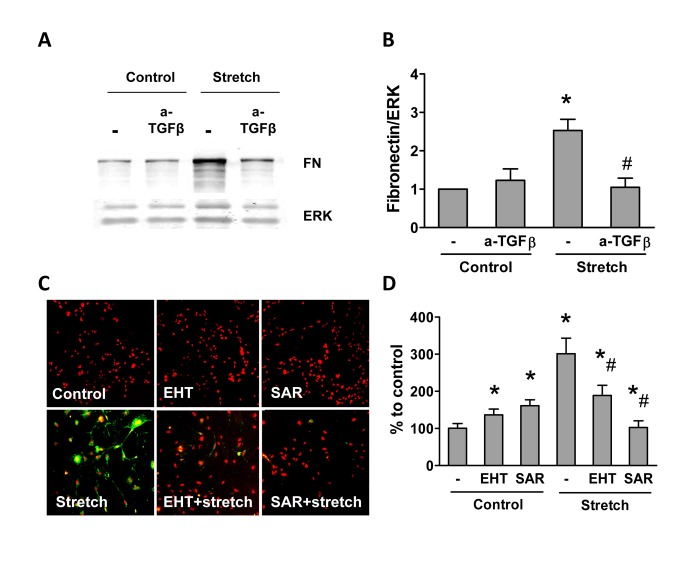
TGFβ mediates stretch-induced signaling in podocytes.Western blot for fibronectin (FN) (A) and quantification (B) of primary podocytes with and without stretch exposure in the absence or presence of anti-TGFβ neutralizing antibody (40 µg/ml). Annexin V activation (G) and its quantification (H) in podocytes with and without stretch-exposure treated with or without EHT (1µM) or SAR (1µM). The data shown are representative of three independent experiments and are means ± SEM (B, D). *P<0.05 vs. corresponding non-stretched control; # P<0.05 vs. stretched control.